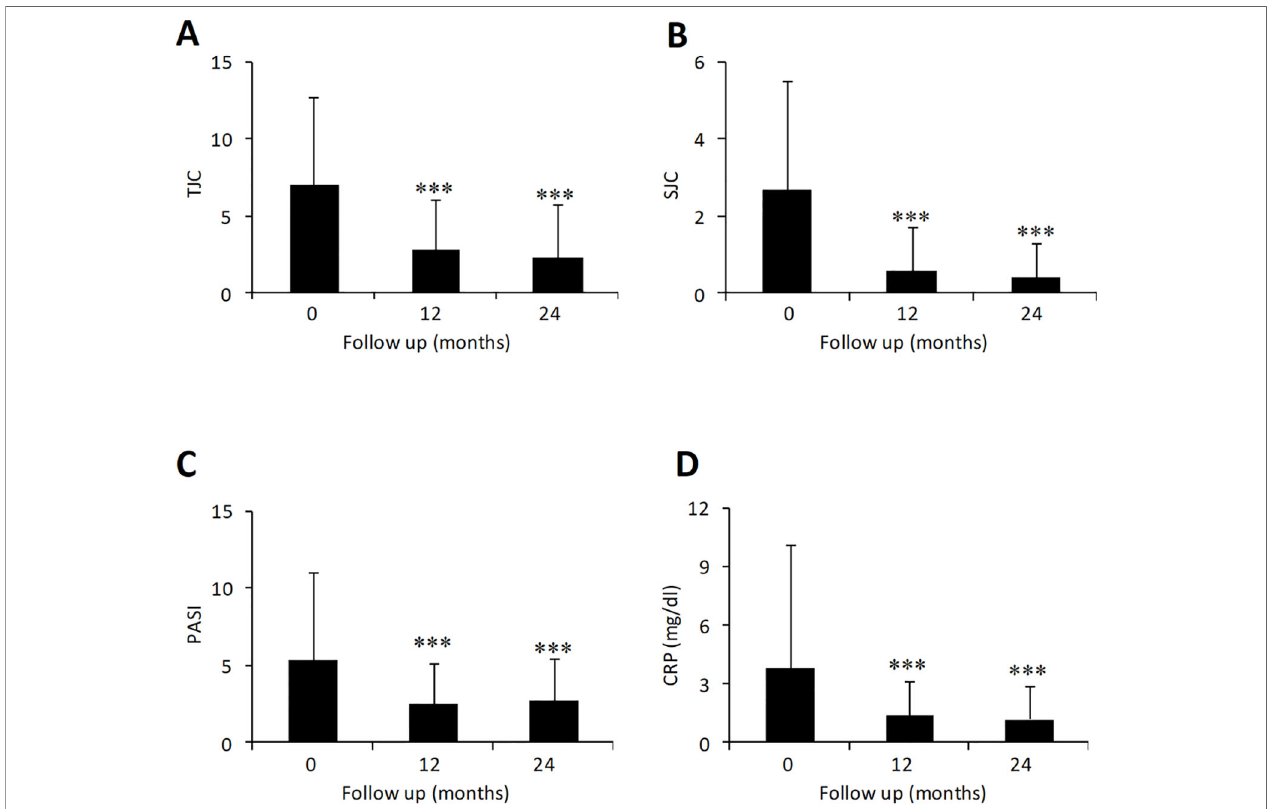
FIGURE 1 | Effect of adalimumab treatment in PsA patients on tender [ (A) N = 303, 271, 275 at 0, 12, and 24 months] and swollen joints [ (B) N = 303, 271, 275 at 0, 12, and 24 months], CRP [ (C) N = 298, 269, 272 at 0, 12, and 24 months] and PASI score [ (D) N = 99, 73, 39 at 0, 12, and 24 months]. CRP, C-reactive protein; PASI, psoriasis area severity index; SJC, swollen joint count; TJC, tender joint count. Data presented as mean ± SD. Asterisks denote statistically signi fi cant differences compared to baseline values after 1-way ANOVA followed by Bonferroni post-hoc